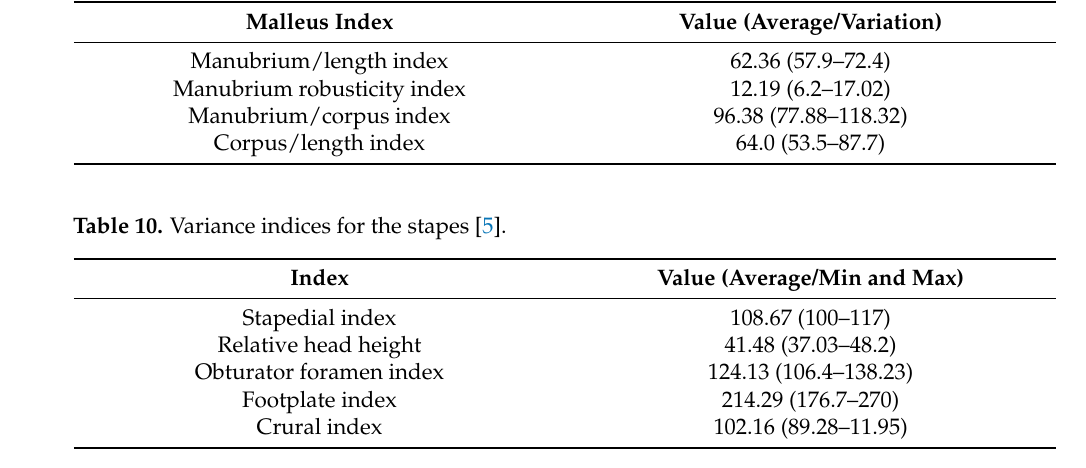
Table 9. Variance indices for the malleus [5].